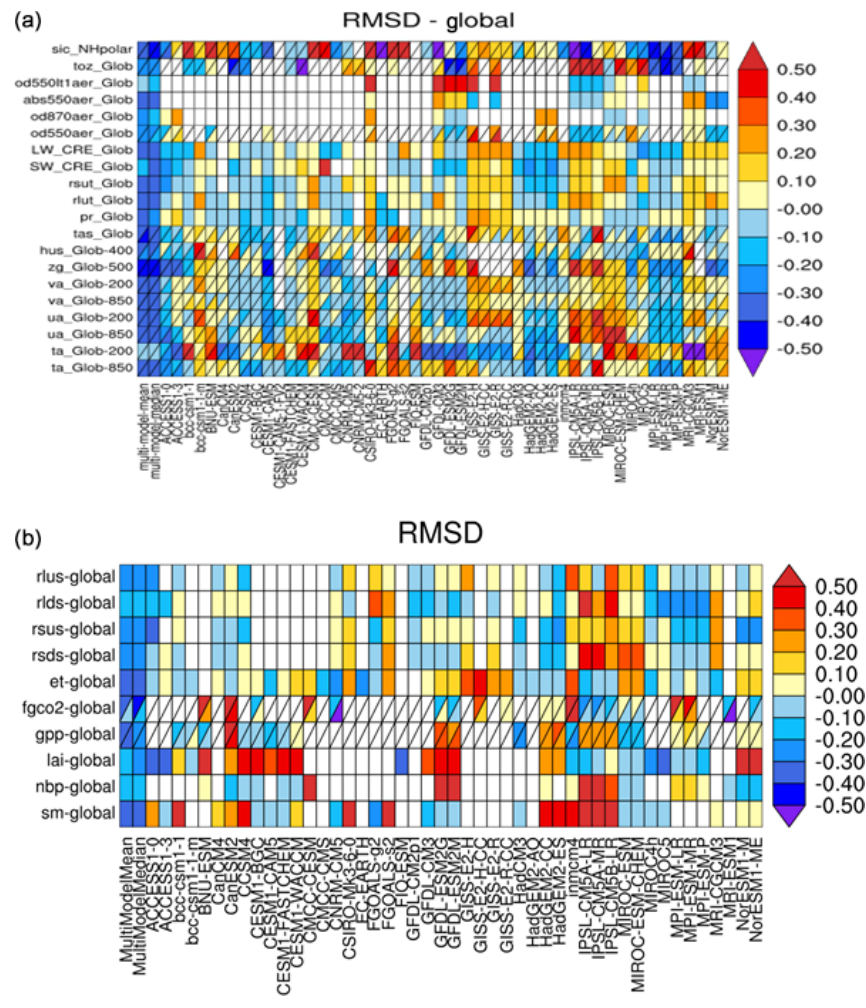
Figure 1. Relative space–time root-mean-square deviation (RMSD) calculated from the climatological seasonal cycle of the CMIP5 simu- lations. The years averaged depend on the years with observational data available. A relative performance is displayed, with blue shading indicating better and red shading indicating worse performance than the median of all model results. Note that the colours would change if models were added or removed. A diagonal split of a grid square shows the relative error with respect to the reference dataset (lower right triangle) and the alternative dataset (upper left triangle). White boxes are used when data are not available for a given model and variable. The performance metrics are shown separately for atmosphere, ocean and sea ice (a) , and land (b) . Extended from Fig. 9.7 of IPCC WG I AR5 chap. 9 (Flato et al., 2013) and produced with recipe_perfmetrics_CMIP5.yml. ; see details in Sect.